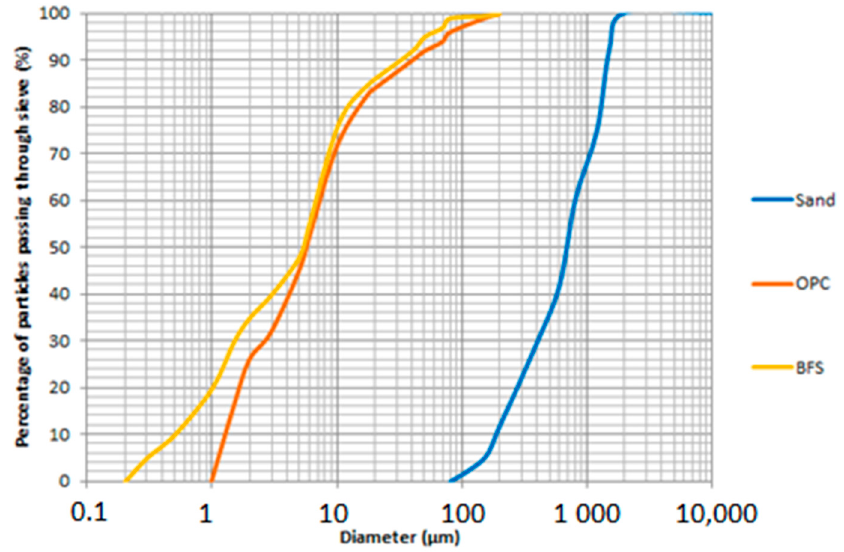
Figure 1. Particle size distribution of the materials used: Blast Furnace Slag (BFS); Ordinary Portland Cement (OPC) and sand.